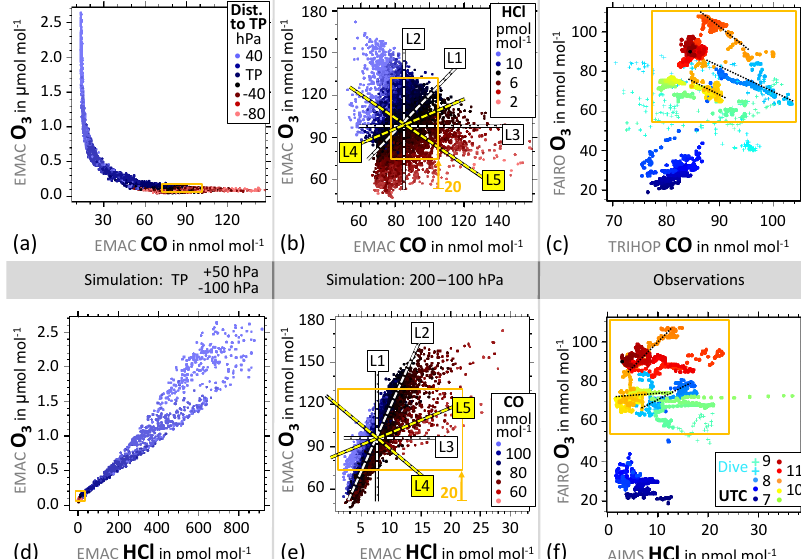
Figure 8. Tracer–tracer relations simulated by EMAC for the whole of September 2012 in the ASMA region and observed by HALO during the HALO ESMVal campaign on 18 September 2012. (a, d) Simulated samples from the region 15–35 ◦ N, 30–100 ◦ E. Colour coding corresponds to the pressure distance to the tropopause, from 100hPa below to 50hPa above. (b, e) Simulated tracer mixing ratios from the same region, but limited to tropospheric cells in the pressure altitude range 200–100hPa. Colour coding indicates corresponding mixing ratios of HCl. See text for details of hypothetic lines L1–L5. (c, f) Observed tracer mixing ratios of the HALO flight from Male to Larnaca (without initial and final stages). Colours correspond to the UTC time of measurement, also indicating spatial proximity. The orange boxes show the ranges covered by the measurements from within the ASMA.